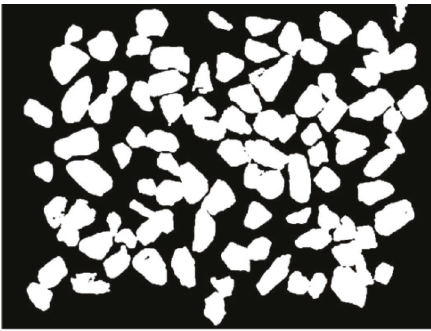
Figure 10: Binary segmentation image. Table 2: Comparison of proposed method with a single detection